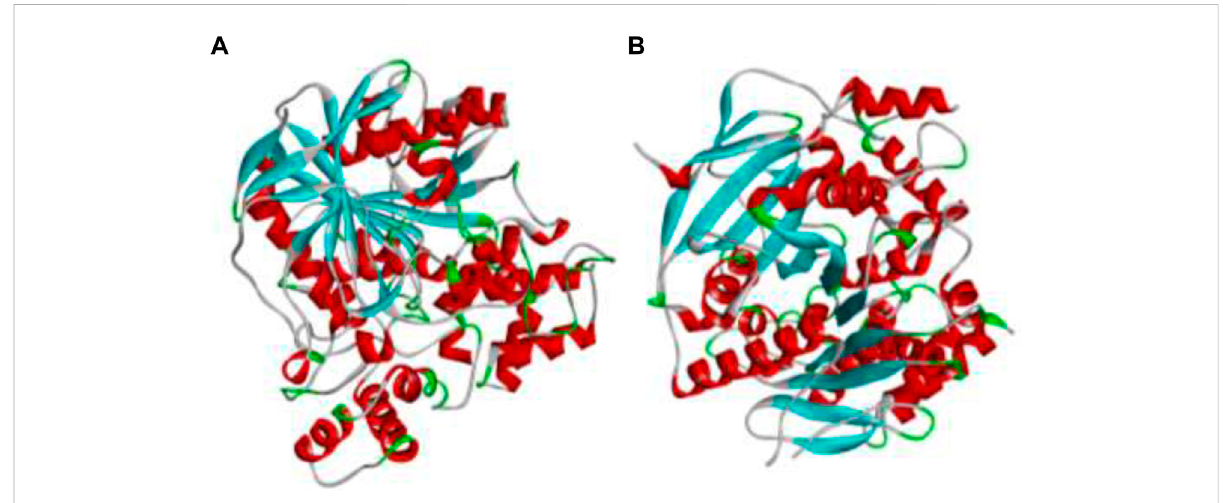
FIGURE 1 The 3D protein structures of (A) BChE (4AQD) and (B) AChE (4EY7) using Discovery Studio 3.1. visualization